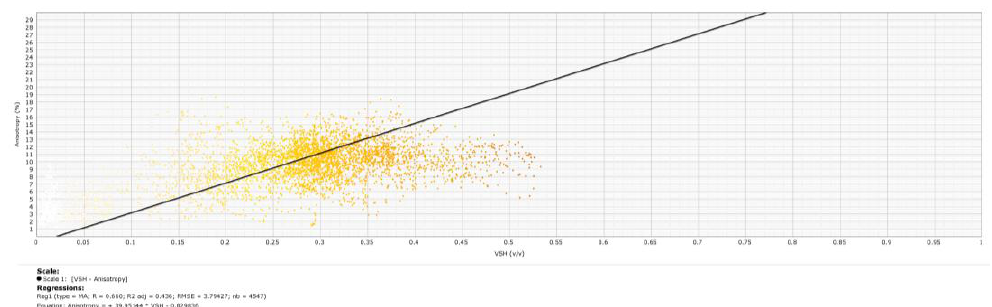
Figure 8. Cross-plot showing VSH in v/v units (x-axis) and dipole acoustic anisotropy in percent (y-axis) in a second well. The cross-plot is colored by VSH values, with lower values in the lighter colors (carbonates) and higher values in the darker colors (shales). The sample size of the dataset (nb) is 4547 datapoints. The correlation (R) between the predictor variable VSH and the response variable anisotropy is 0.660.